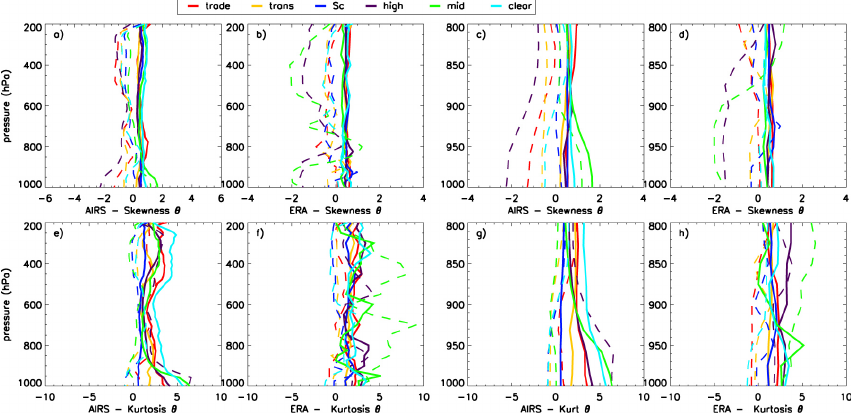
Fig. 6. The same as Fig. 5 except for the skewness and